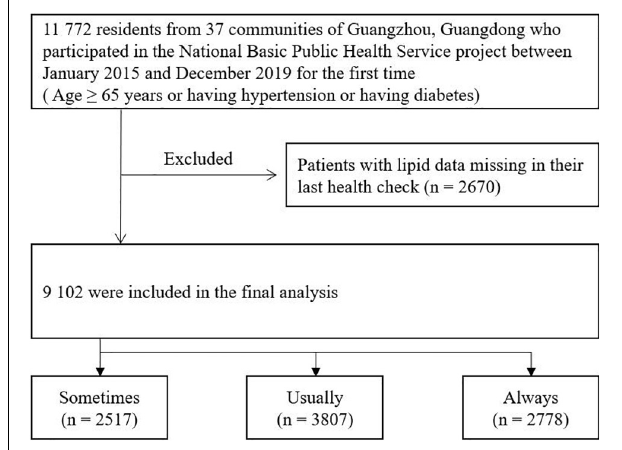
FIGURE 1 | Flowchart of the case selection progress.